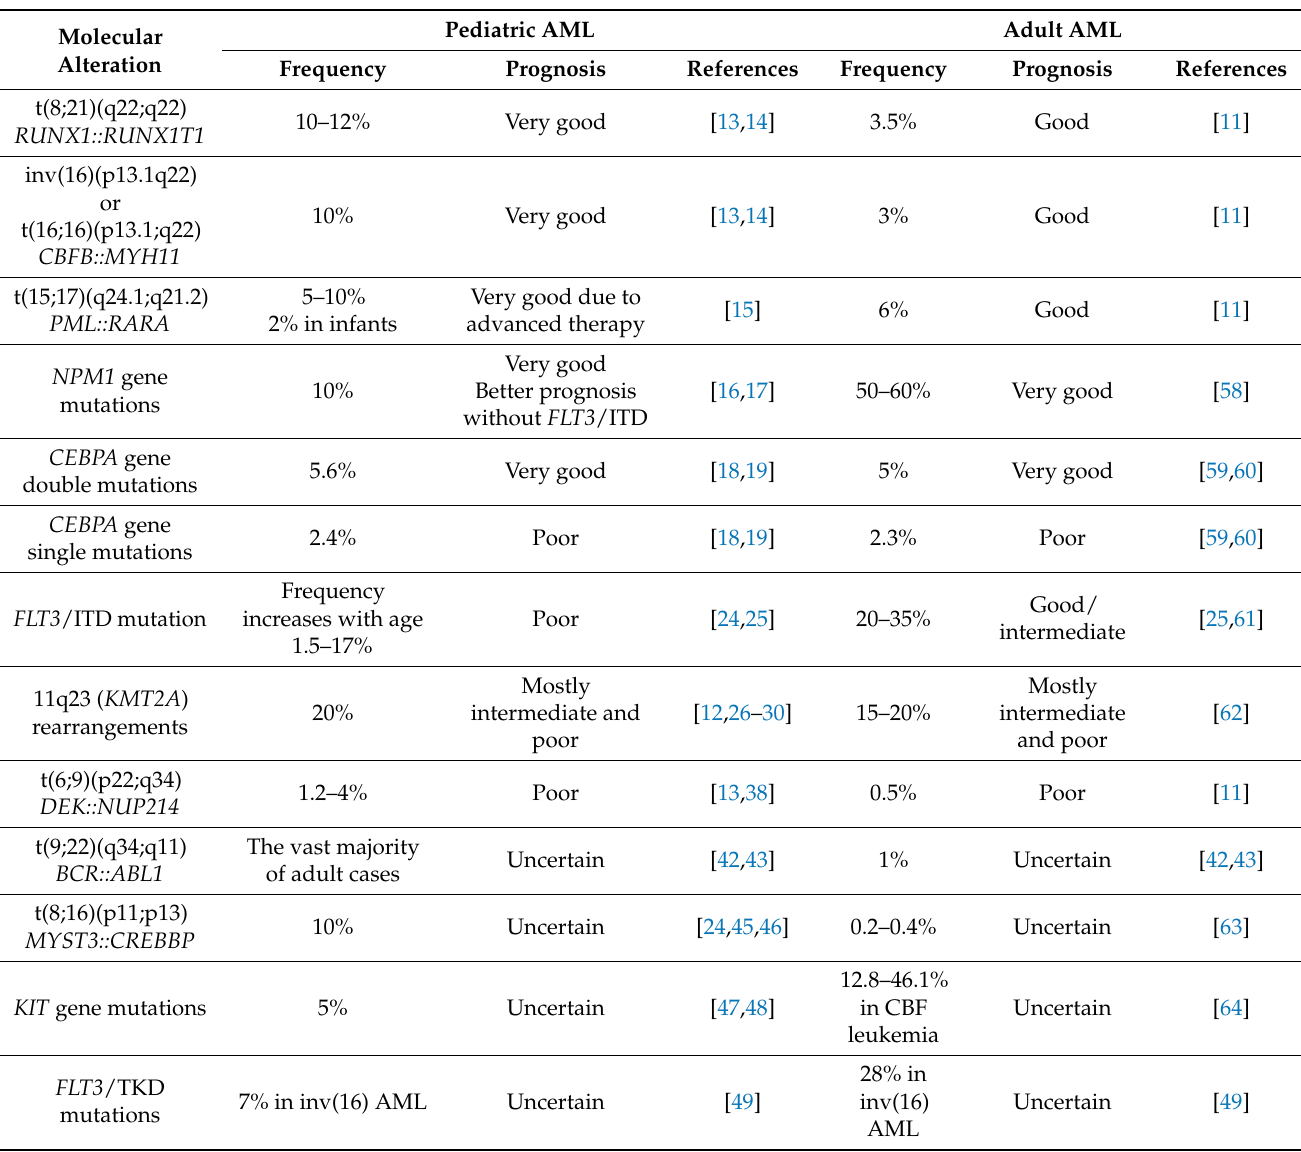
Table 2. Differences in adult and pediatric AML